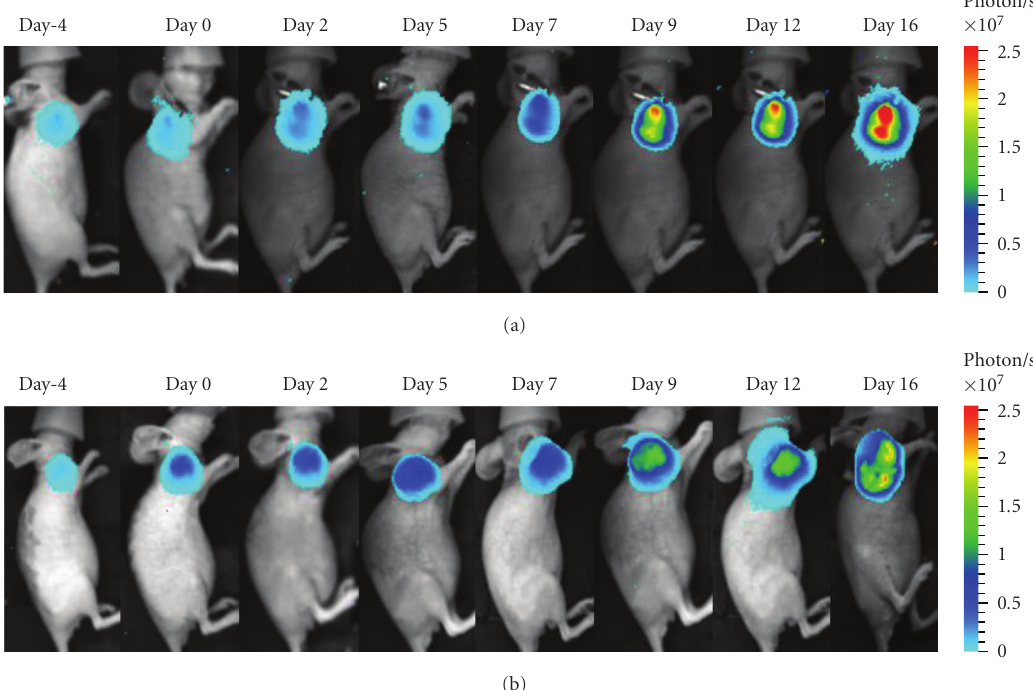
Figure 1: Serial bioluminescence images of the HCC-LM3-fLuc tumor-bearing nude mice that underwent saline (a) or cyclophosphamide (b) treatment (data from Ma et al.